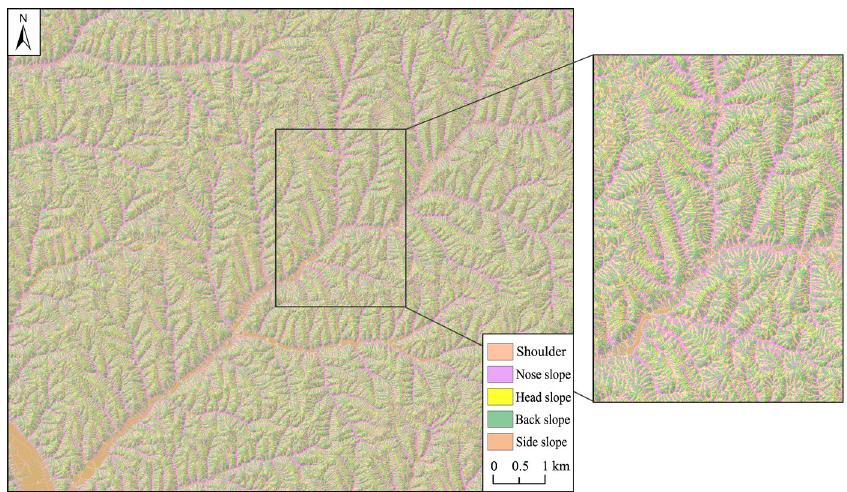
Figure 10. Terrain positions classified by the pixel-based classification method using the rules at the second level.